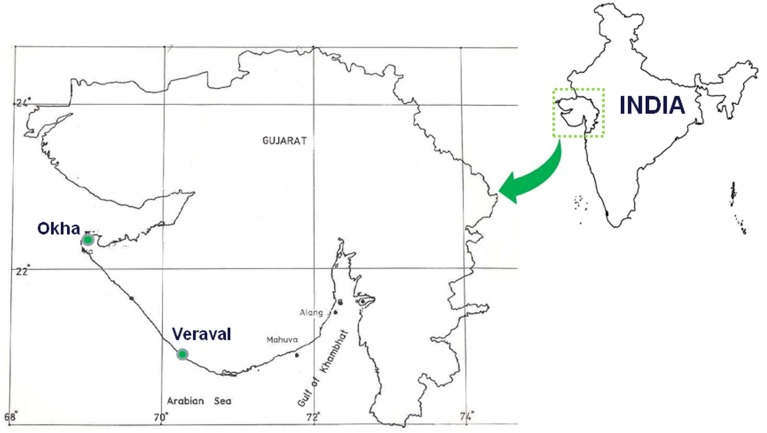
Map of Gujarat showing macroalgal sampling locations. The land mass showing collection spots is flanked by Gulf of Kutch on northern part (Okha) and Gulf of Khambhat (Veraval) on southern part of Gujarat (Northern west coast), India.